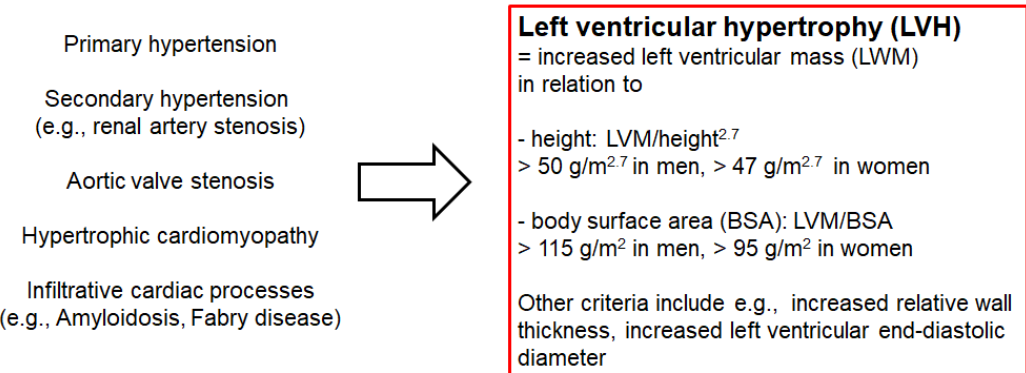
Figure 1. Different (patho-)physiologic conditions that can lead to left ventricular hypertrophy (LVH) in humans. Various CVDs as well as athletic training are associated with LVH. According to the American Society of Echocardiography and the European Association of Cardiovascular Imaging, LVH is defined as an increased left ventricular mass (LVM) in relation with height or body surface area. LVH can be determined via echocardiography or cardiac magnetic resonance imaging. Micro (mi)RNAs are short (~22 nucle-